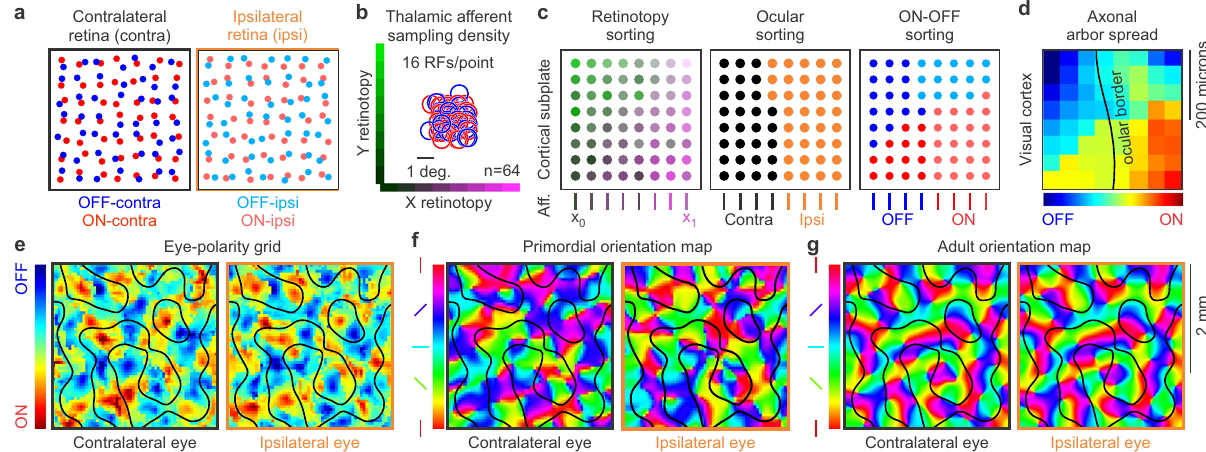
Fig. 2 Main stages of the computational model. a Retinal development. Model simulations of ON and OFF retinal ganglion cells (red and blue circles) from the contralateral and ipsilateral eyes (high and low contrast). b Receptive fi elds (RF) of 64 thalamic afferents receiving input from the retinas illustrated in a and thalamic afferent sampling density (16 receptive fi elds sampling the same visual point). c Model simulations of the afferent sorting in the cortical subplate. The 64 afferents (Aff.) illustrated in b are sorted fi rst by retinotopy (left), then by eye input (middle) and then by ONOFF polarity (right). d Model simulations of the eye-polarity grid after the afferent axon arbors spread and combine in each cortical pixel (red: ON dominated, blue: OFF dominated, black line: border between regions dominated by contralateral and ipsilateral eyes). e Model simulations of the eye-polarity grid in a larger cortical patch. f Primordial orientation maps for the contralateral (left) and ipsilateral eyes (right) resulting from thalamocortical convergence. g Adult orientation map after the primordial map is optimized by visual